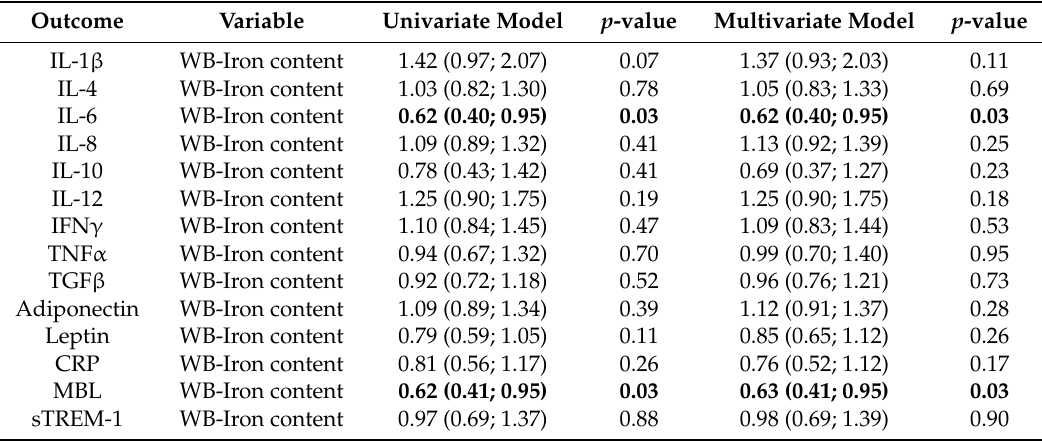
Table 2. Relative change in mean levels of cytokines, adipokines, and other proteins involved in the immune response with 95% confidence bands by 1 unit increase in neonatal whole blood iron content—results from models without correction for multiple testing.